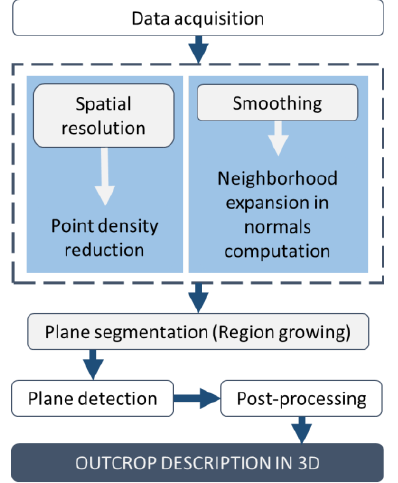
Figure 1. Workflow of studying automatic plane detection in geological outcrop data using 3D point clouds directly